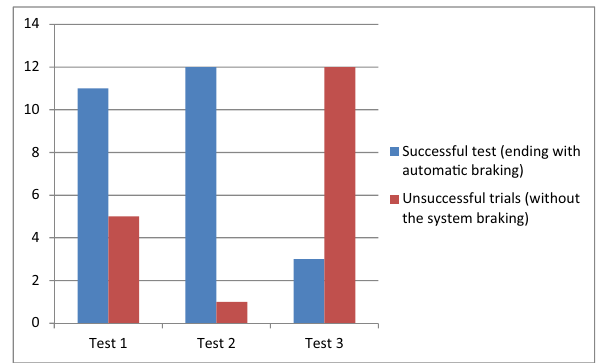
Figure 15: Distribution of trials in the individual scenarios. Source: “ authors ” own study.